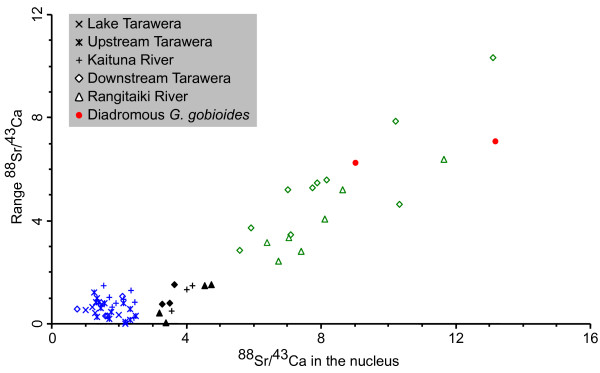
Nucleus counts against range of normalised 88Sr/43Ca in G. cotidianus and two obligatorily diadromous G. gobioides (red solid dots) included in this study. Colours refer to migratory types: blue = non-diadromous, green = diadromous. Black solid symbols were not confidently attributable to either category based on nucleus vs range counts.